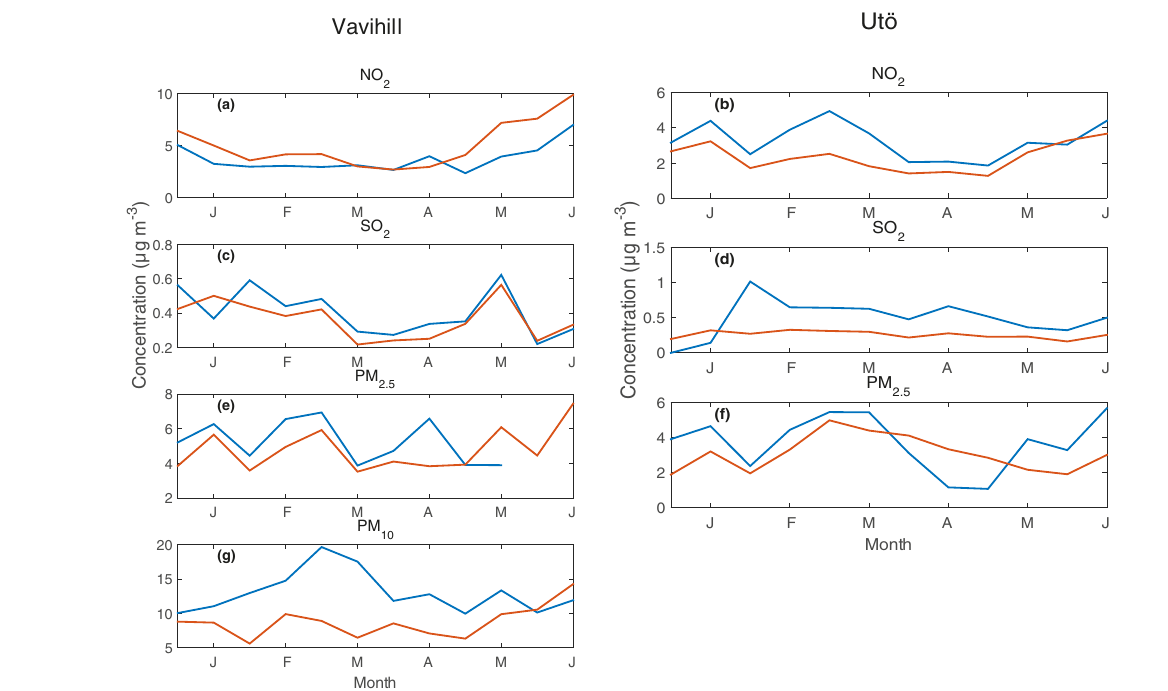
Figure A2. Measured and modelled monthly average of concentrations of the pollutants at Vavihill and Utö in 2013. The red line corre- sponded to concentrations of the EMEP modelling and the blue line showed measured